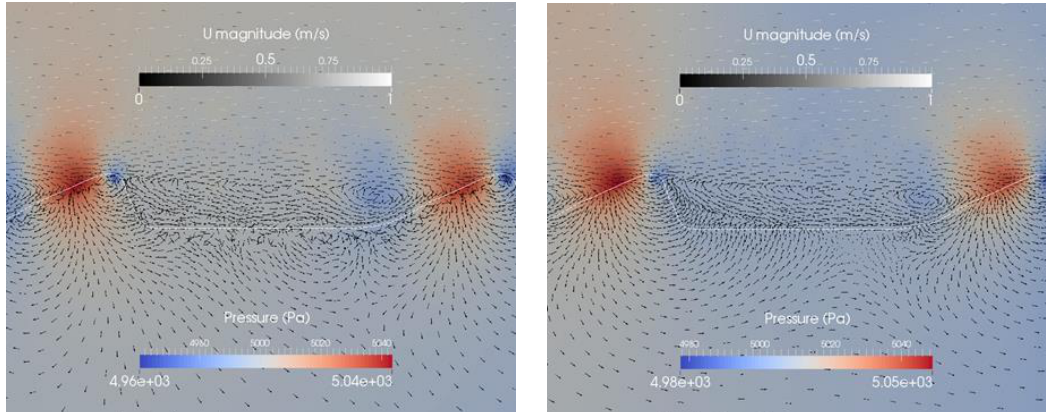
Figure 11. Pressure distribution and velocity vectors at a sandy ( left ) and gravel ( right ) ripple for case 5 (Table 1). The white line indicates the sediment-water interface. The colors indicate the pressure distribution. Please note that the scaling is different in the right and the left panel. The arrows indicate flow directions of the surface and the subsurface flow. To visualize the intensity of the flow U a grey is used.